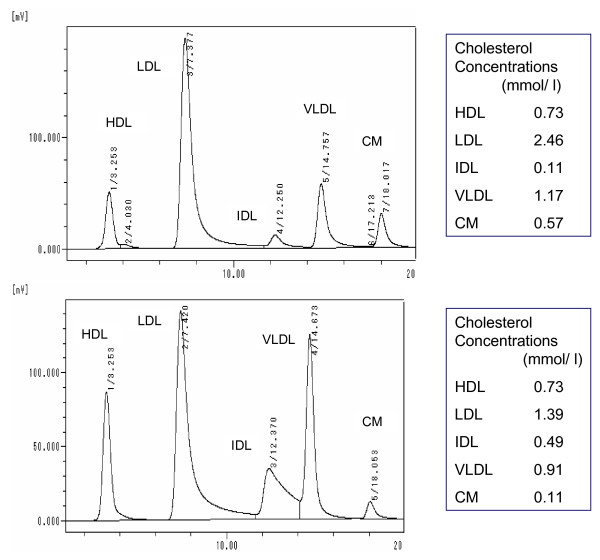
HPLC chromatograms of lipoproteins from the discrepant samples. Upper and lower panels indicate the HPLC lipoprotein chromatograms of the samples with RemL-C value < RLP-C value and with RemL-C value > RLP-C value, respectively. CM means chylomicron.